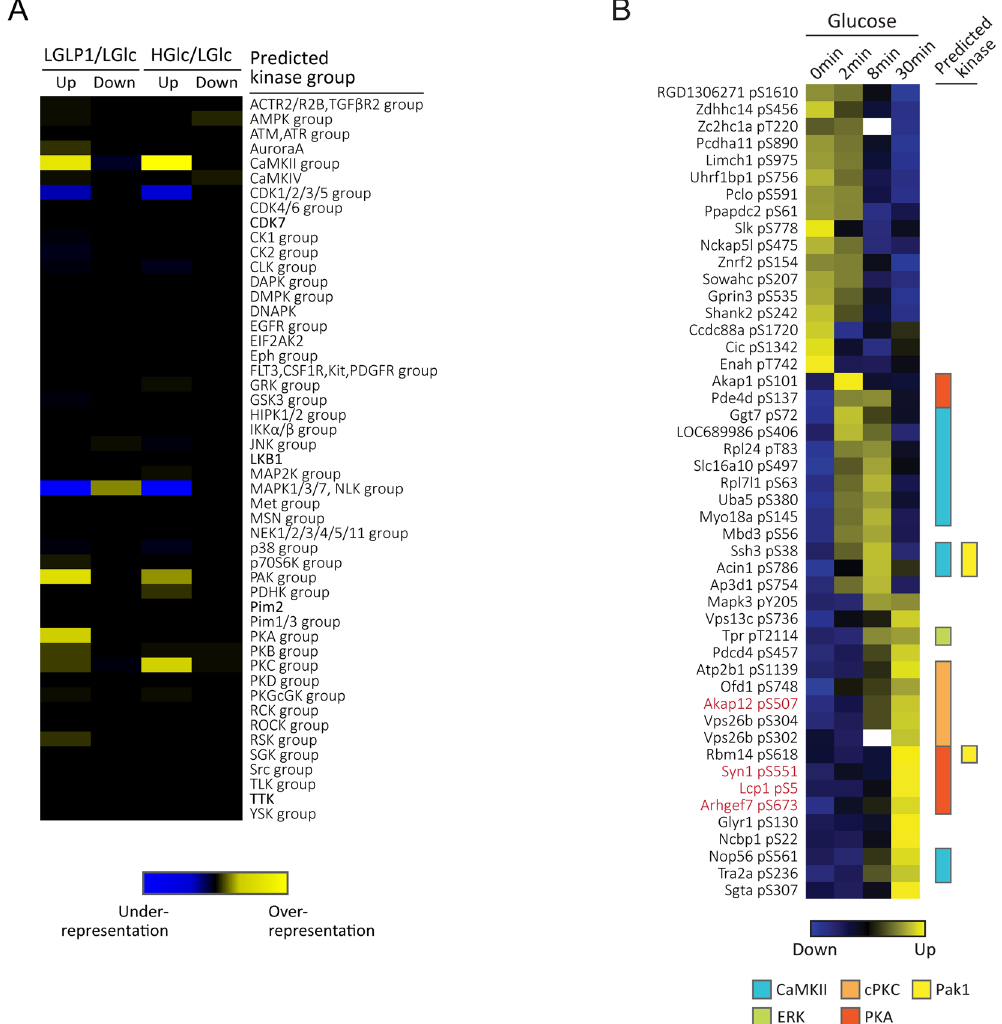
Figure 2. Kinase-substrate prediction. (A) Heat map of secretagogue regulated kinase substrates. Kinase substrate prediction was performed using NetworKIN 3.0. High confidence regulated sites (up and down- regulated) were compared to quantified phosphorylation sites for kinase group substrates enrichment. The heat map shows over- (yellow) and underrepresentation (blue) of predicted kinase substrates among regulated sites. (B) Heatmap showing the glucose treatment temporal profiles of phosphorylation sites regulated by both GLP-1 and glucose. Only phosphorylation sites regulated by both GLP-1 in the glucose/GLP-1 synergism experiment (Exp1 in Fig. 1A) and by glucose in the glucose time course experiment (Supplementary Fig. S3A) were plotted. Kinases predicted by NetworKIN algorithm of each site are listed on the right side. Characters in red represent the reported kinase-substrate